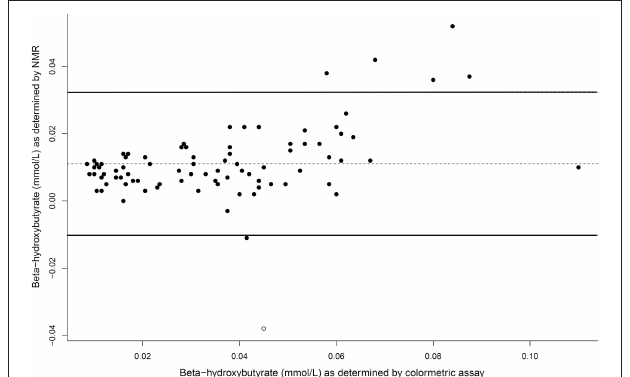
FIGURE 5 | A Bland Altman comparison plot of beta-hydroxybutyrate concentrations as assay by the colormetric kit and by nuclear magnetic resonance (NMR). At y = 0, this indicates perfect agreement, with the middle line as the actual agreement. The solid lines represent the 95% limits of agreement of the data.